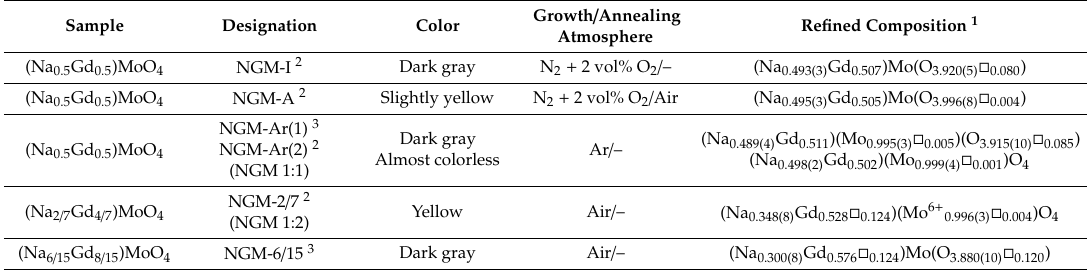
Table 6. Growth and post-growth conditions, color and refined compositions of (Na, Gd)MoO 4 (NGM) crystals according to single-crystal X-ray di ff raction (XRD)